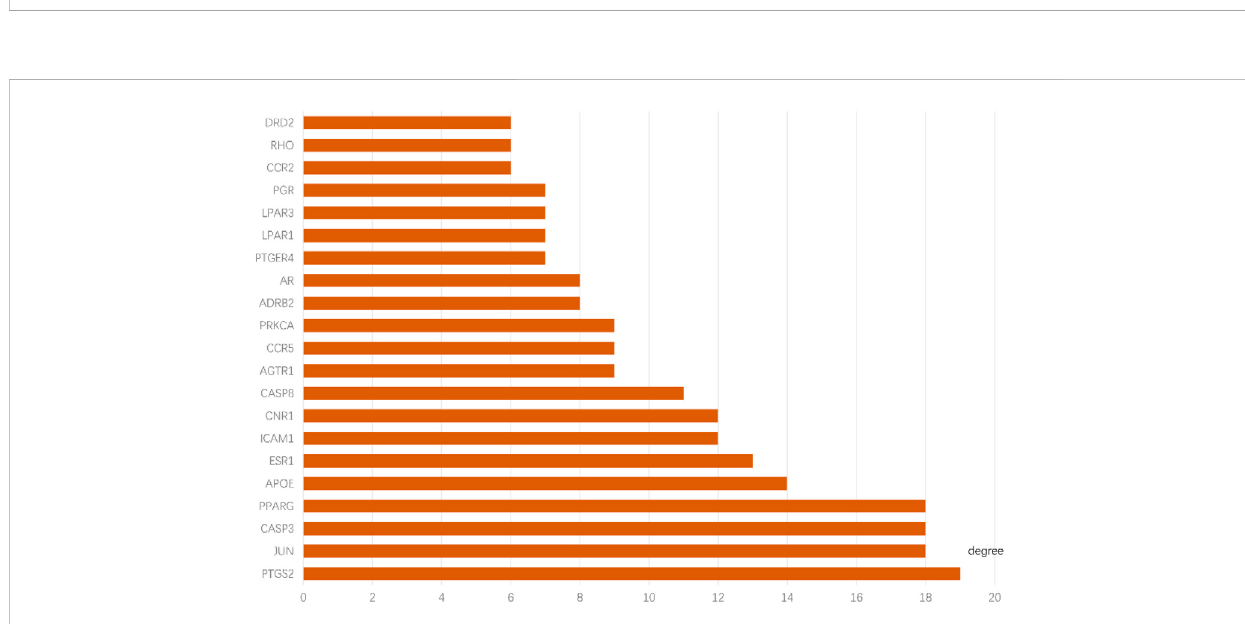
FIGURE 6 Key targets for the treatment of RA with SA. the y-axis displays signi fi cant top 21 genes, and the x-axis shows degree counts of these genes.